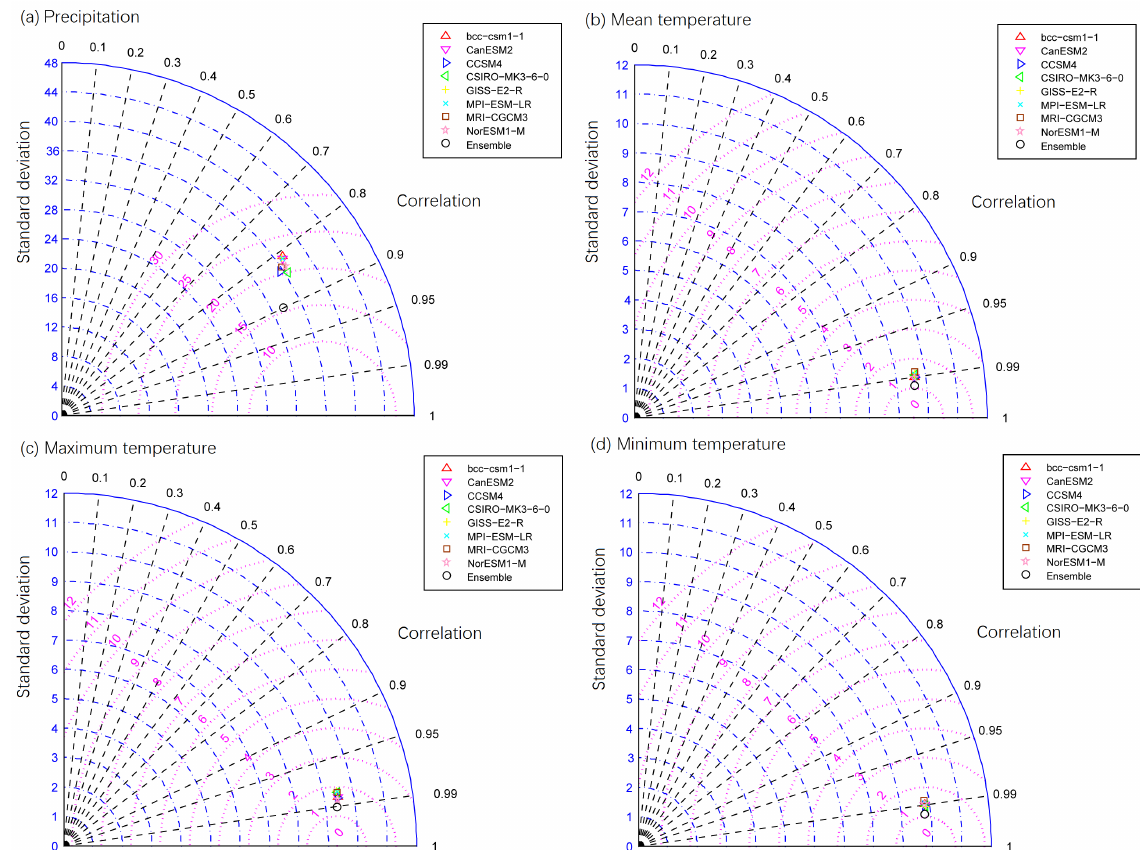
Figure 2. Taylor diagram of standard deviation and correlation of observed and downscaled (a) monthly precipitation, (b) mean temperature, (c) maximum temperature, and (d) minimum temperature in YRB